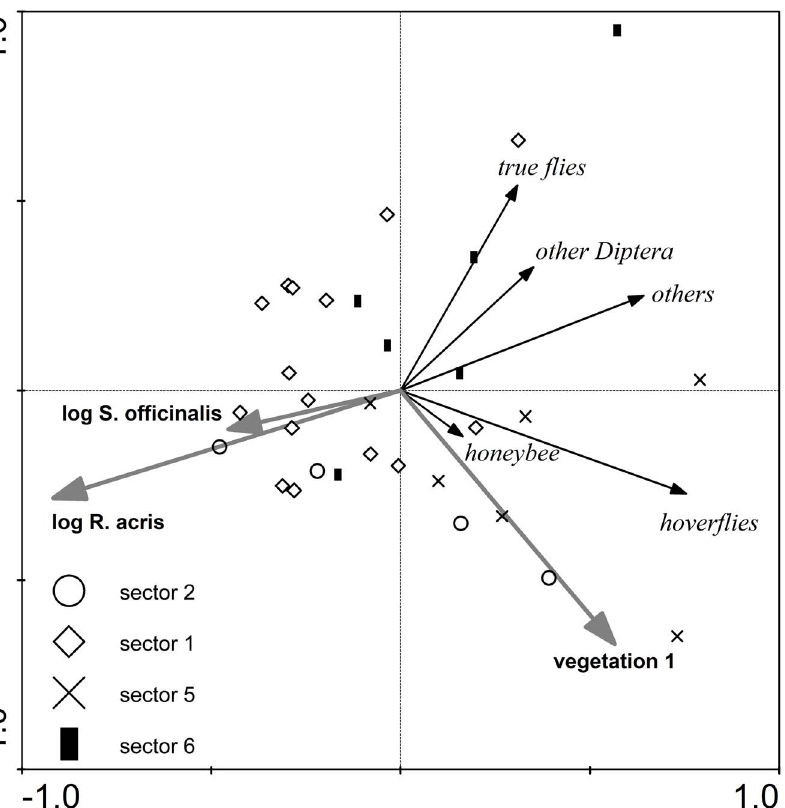
Figure 4. Ordination diagram of RDA analysis of pollinator densities on Hypericum spp. Environmental variables included in the final model, based on forward selection were: logarithm of flowering stalk abundance of Hypericum spp. (Hypericum (log); plots were categorized according to the sector in which they were located (see Fig. 1 for definition of sectors); 1 st ordination axis (canonical) explains 27.5% of total variability in pollinator density, 2 nd axis (non-canonical) explains 30.2%.